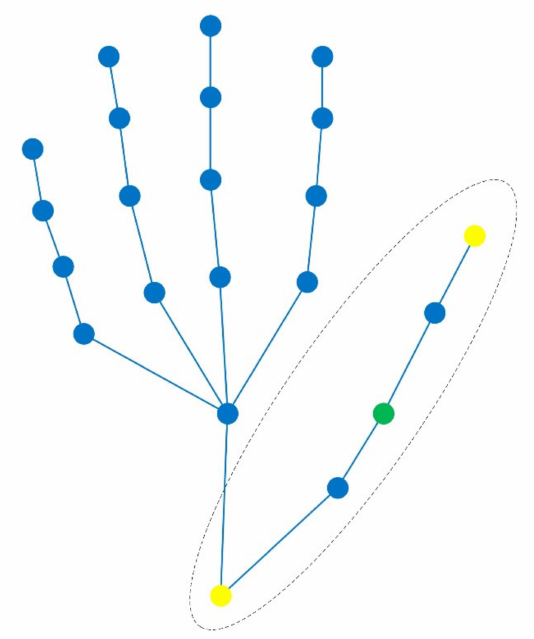
Figure 3. Dilated convolution form on hand skeleton map.